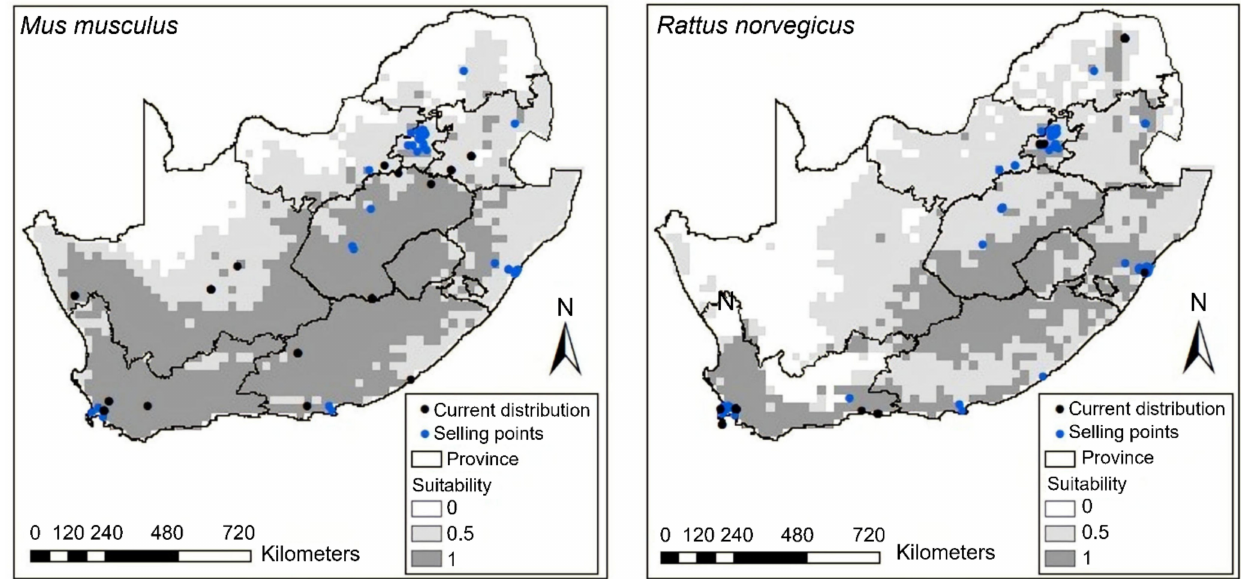
Figure 2. The potential distribution of house mice ( Mus musculus ) and Norwegian rats ( Rattus norvegicus ) predicted by species distribution model with the human footprint (Note: The color ramp threshold on the right measured the suitability: dark gray indicates the most suitable areas, decreasing to light gray, with white being